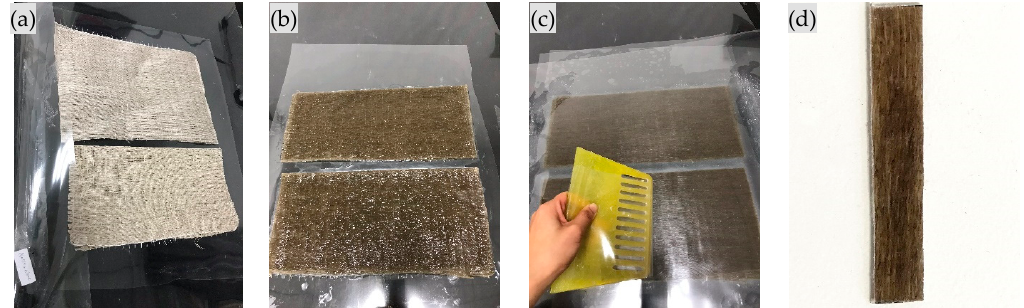
Figure 1. Fabrication of flax fiber reinforced polymer (FFRP) specimen: ( a ) flax fabric; ( b ) coating with epoxy; ( c ) remove bubbles; ( d ) cut into desired shape.